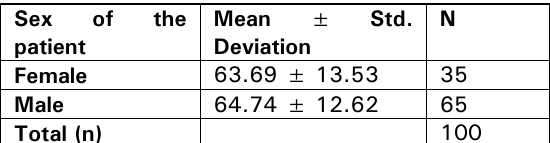
Table 2: Comparison of ECG changes in Ischaemic and Haemorrhagic Stroke on the basis of